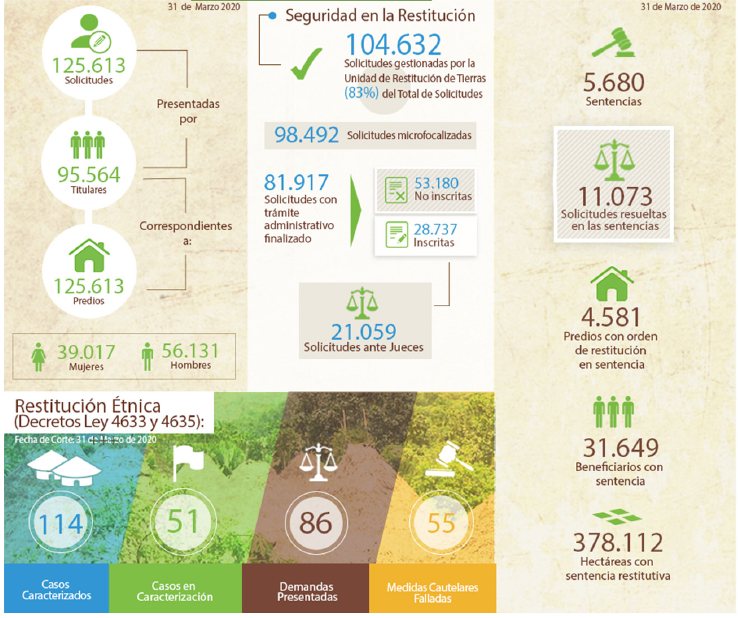
Figure 1. The current statistics on land restitution in Colombia. Source: Figure1. ThecurrentstatisticsonlandrestitutioninColombia. Source: https: // www.restituciondetierras. https://www.restituciondetierras.gov.co/estadisticas-de-restitucion-de-tierras. Accessed 3 May 2020. gov.co / estadisticas-de-restitucion-de-tierras. Accessed 3 May